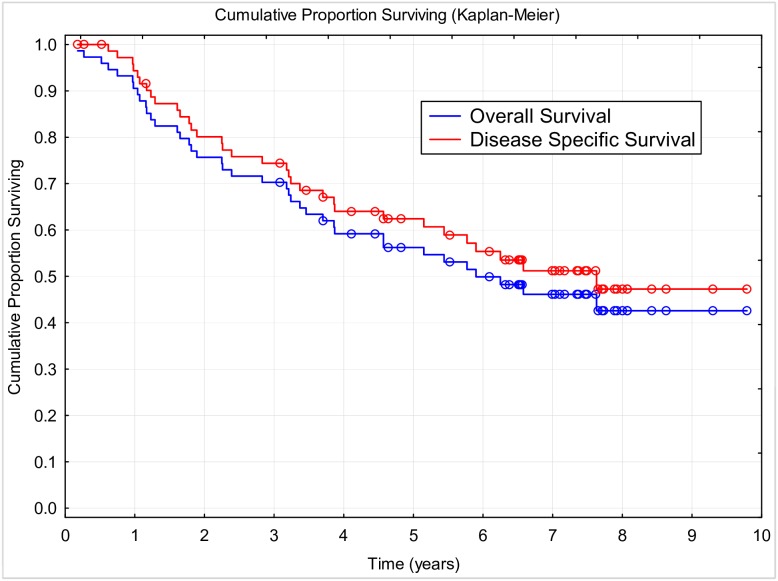
Overall survival and disease specific survival.